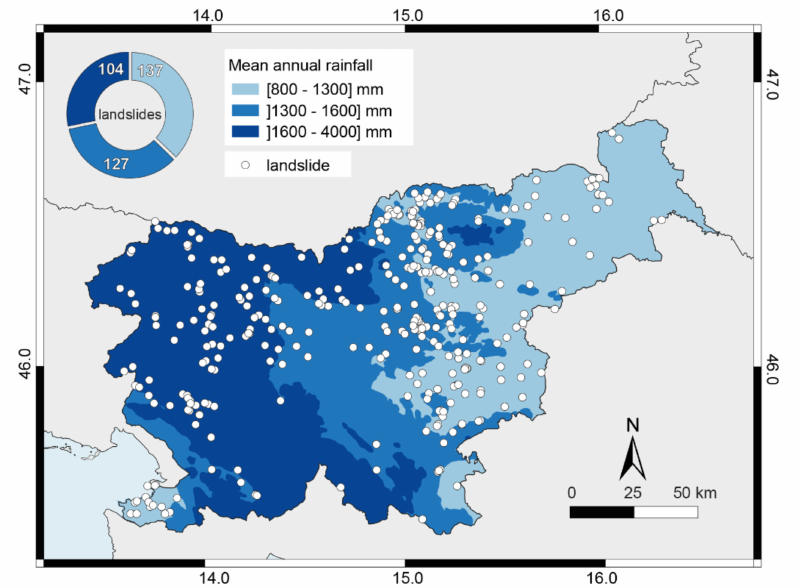
Figure 4. Subdivision of Slovenia based on di ff erent mean annual rainfall (MAR) between 1981 and 2010 [42] into three classes, with indication of the landslides used in the analysis. The donut chart shows the number of landslides in each